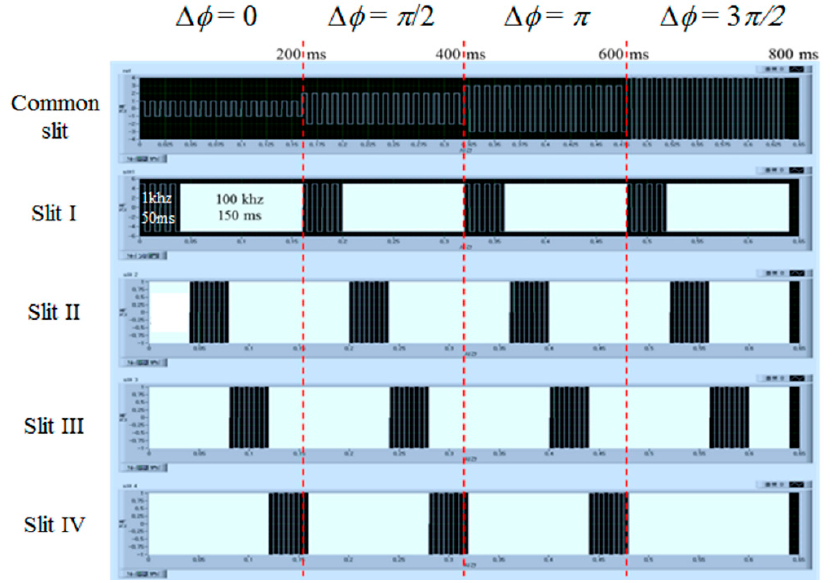
Figure 7. Driving waveforms of voltages applied to the LC layer on each slit of the DFPG utilizing the dual-frequency modulation for projecting 16 fringe patterns with the four different multi-spatial frequencies and the four-step phase shifting within the fast switching time.